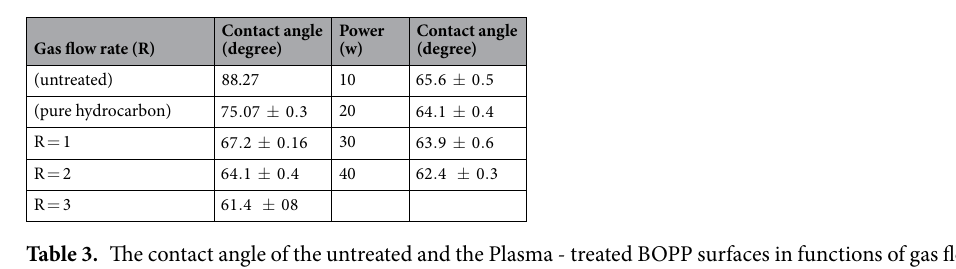
Table 3. The contact angle of the untreated and the Plasma - treated BOPP surfaces in functions of gas flow rate (R =